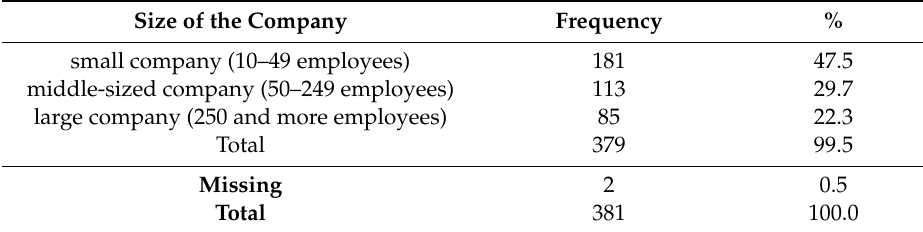
Table 1. Research sample according to size of the